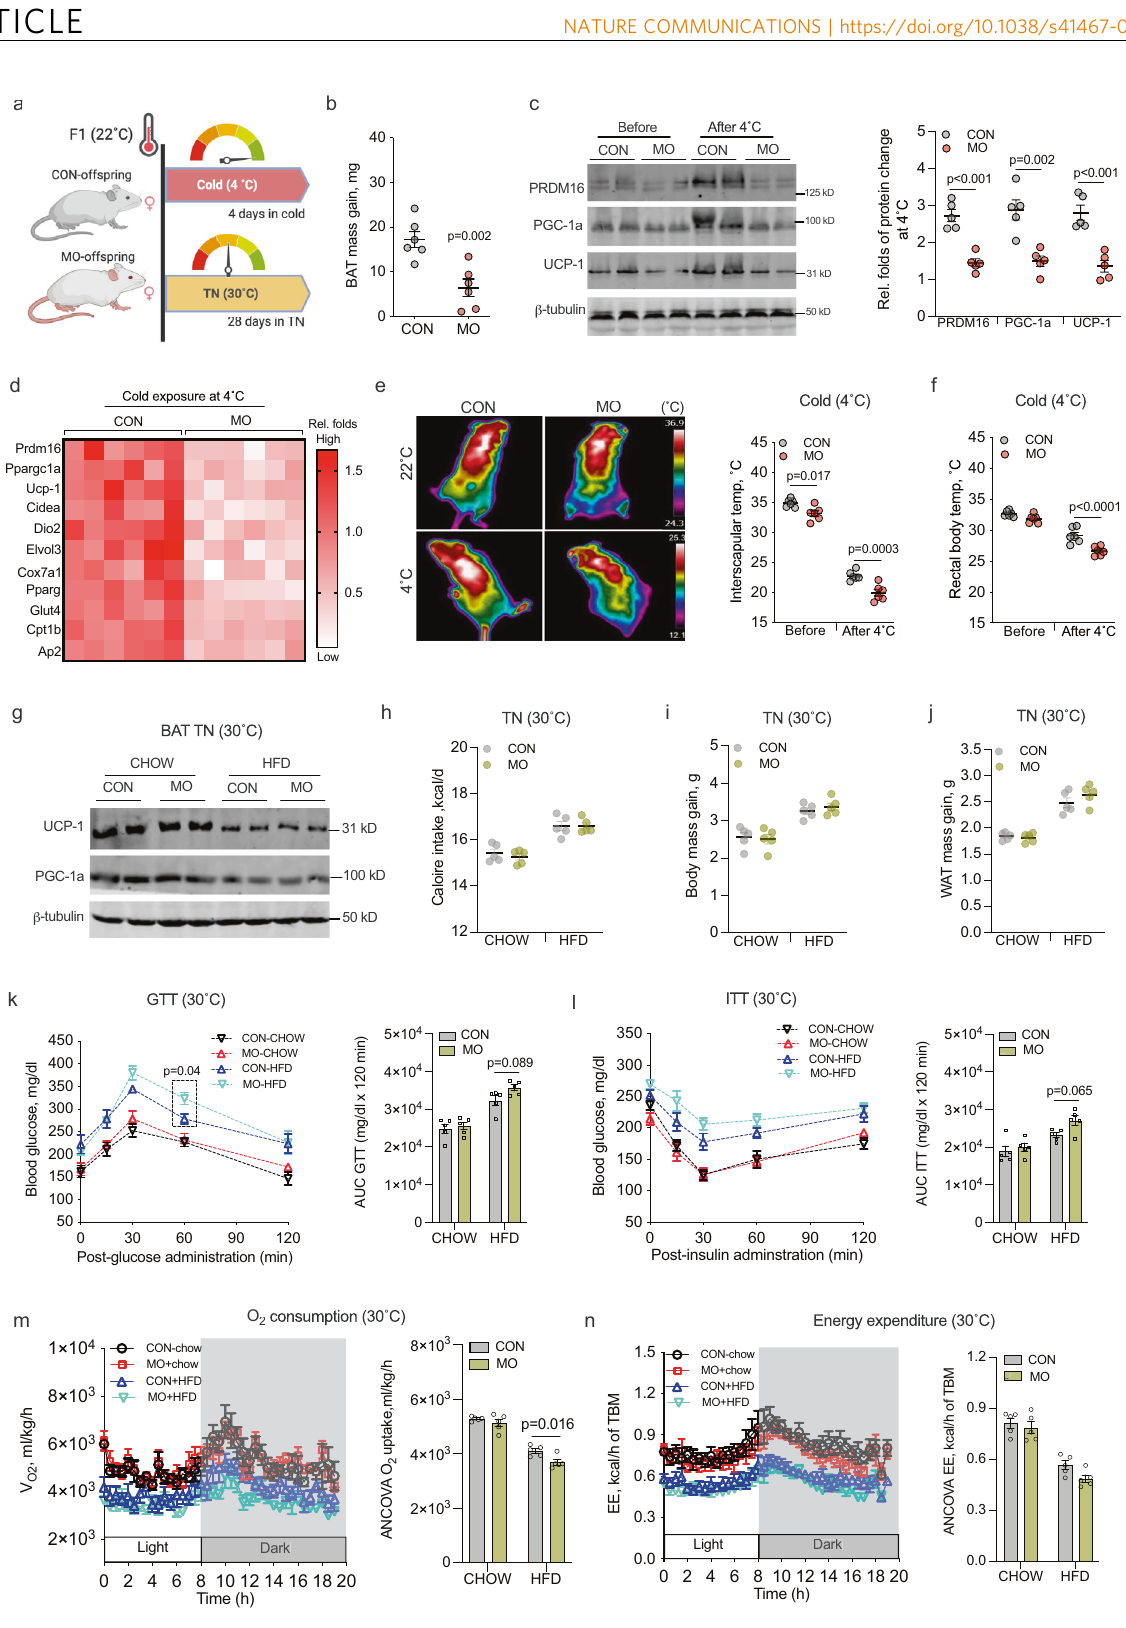
metabolic dysfunction in MO female offspring under HFD and cold exposure. Impaired brown adipogenesis in MO female offspring has a fetal origin. We next examined the developmental origin of BAT thermogenic impairment in MO female offspring. Reduced